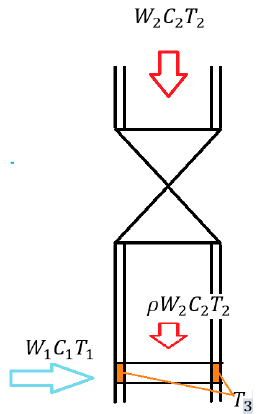
Figure 6. Sketch of the water tube with a reduction in inlet flow.